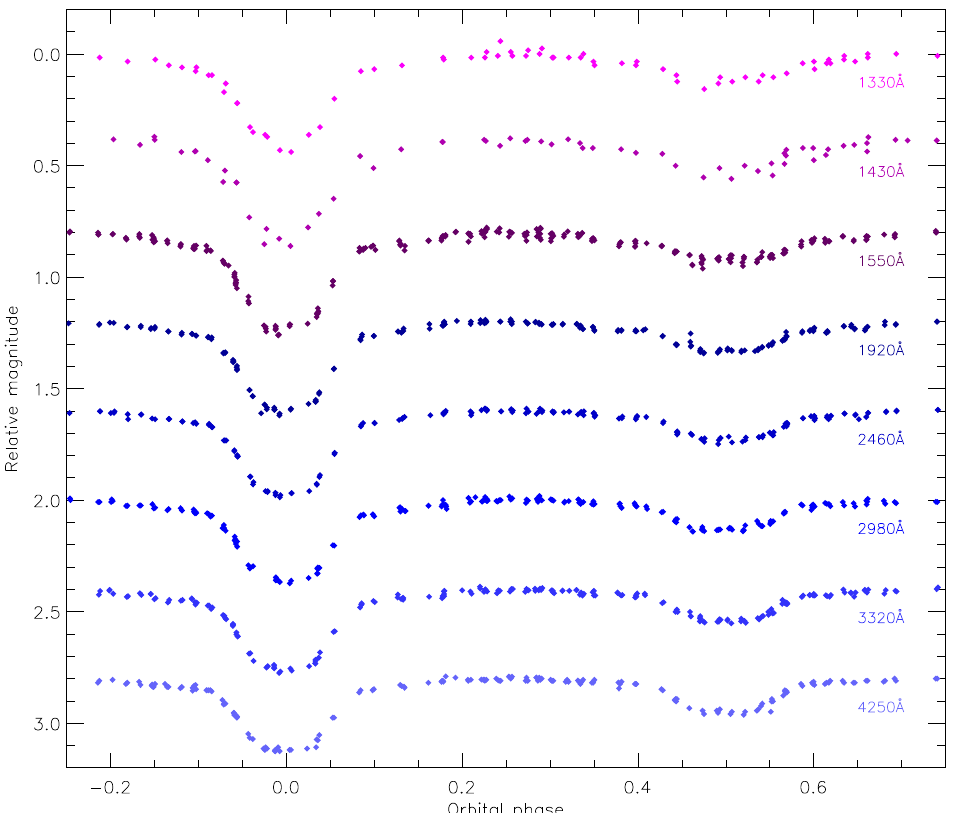
Figure 2. The OAO-2 satellite light curve of the EB VVOri ( P = 1.485d) in seven UV passbands (labelled), published by Eaton